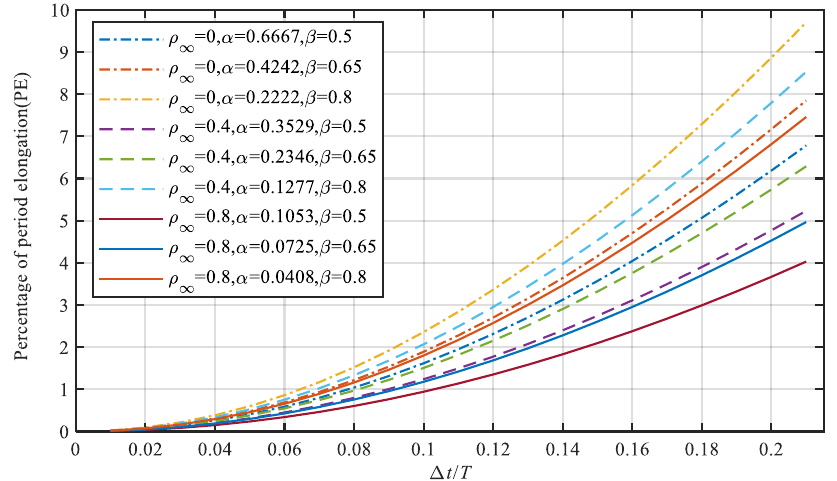
Figure 2. Percentage of period elongation of the proposed method with different numerical damp- ing.